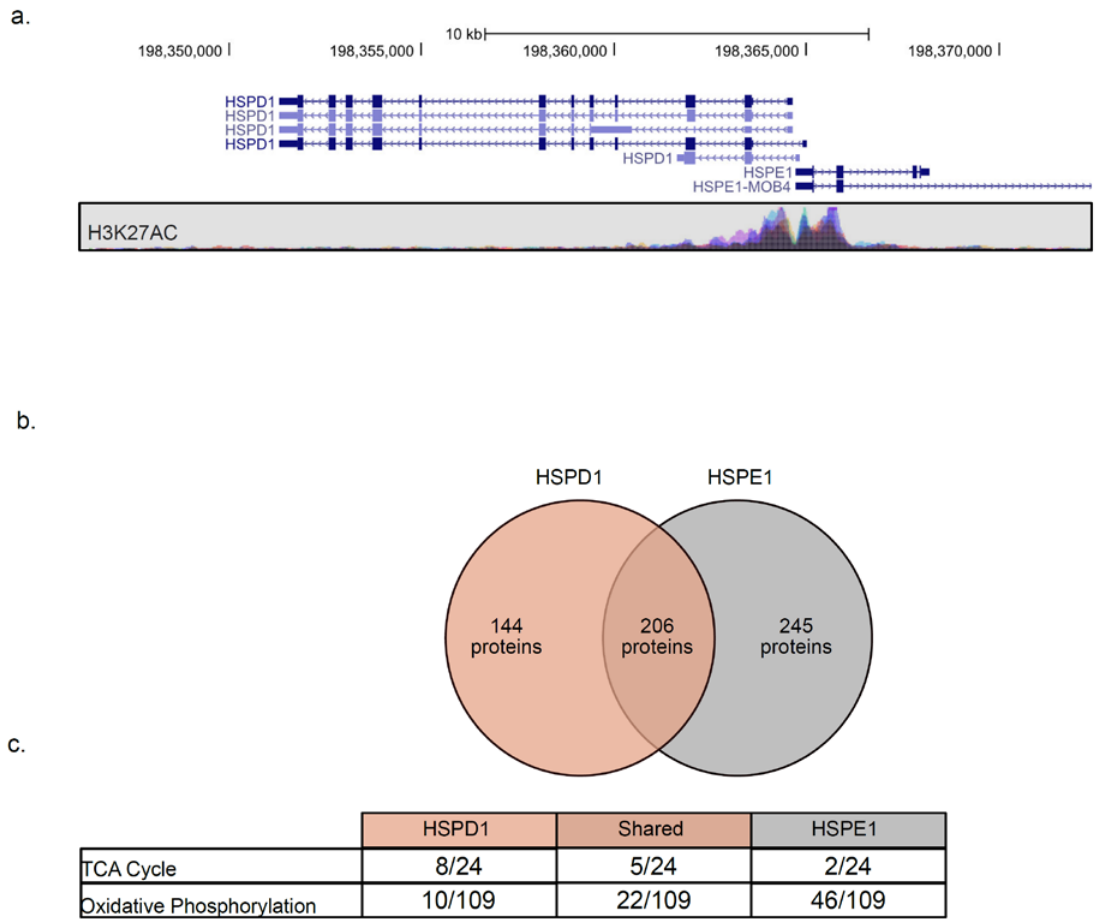
Figure 5. HSPD1 and HSPE1 share a promoter but are co-expressed with distinct mitochondrial proteins. ( a ) The genomic location and K27acetylation of HSPD1 and HSPE1 were obtained from the University of California Santa Cruze (UCSC) genome browser. ( b ) Venn diagram representing proteins co-expressed with each chaperone. ( c ) IPA analysis of each group of proteins identified in b depicts the number of proteins found to belong to the specific pathway and the total number of proteins in the pathway.